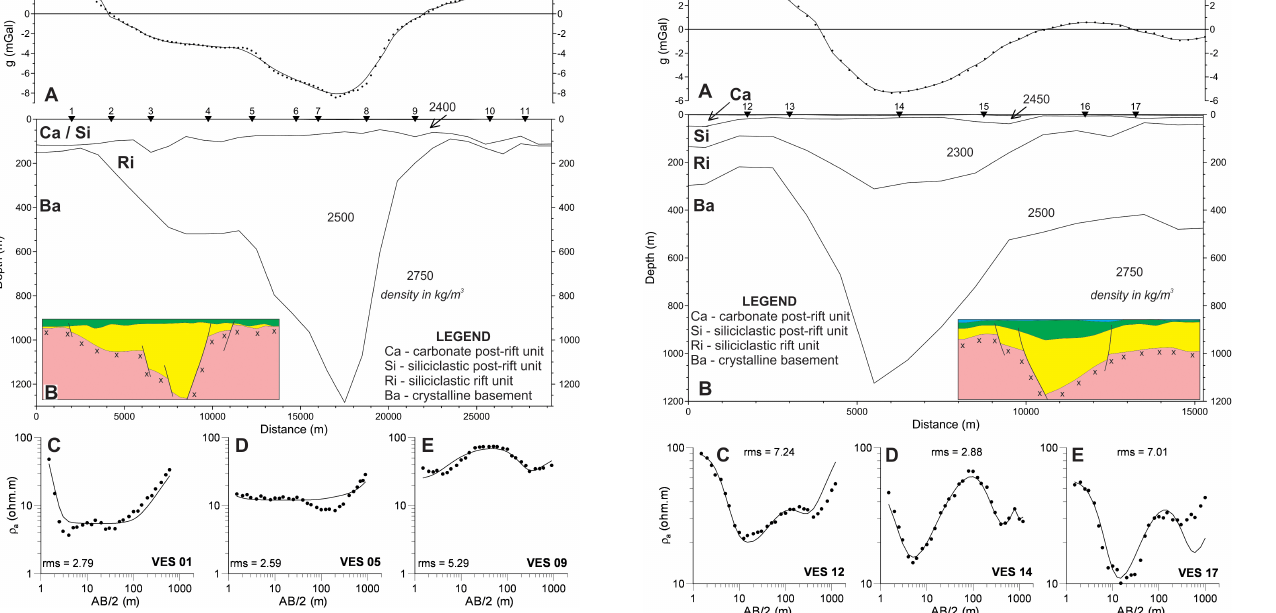
Figure 9. Observed (dots) and calculated (solid line) gravity anomaly across profile 02 (a) and the final model response obtained from joint inversion method (b) . Comparison of three VES data (dots) and model responses of the gravity–geoelectric joint inver- sion (c–e) . rms: VES misfit (per